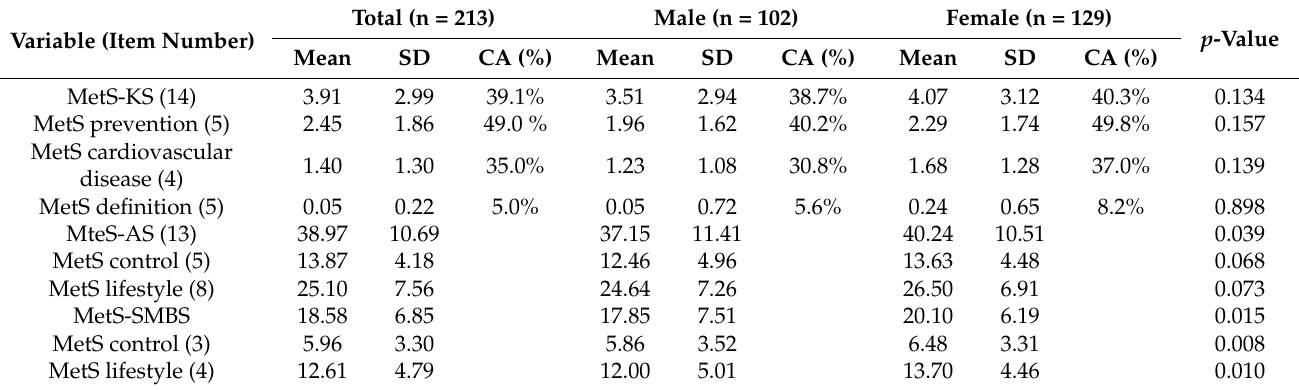
Table 3. Mean scores on MetS knowledge, attitude, and self-management behavior scales and their domains (n =